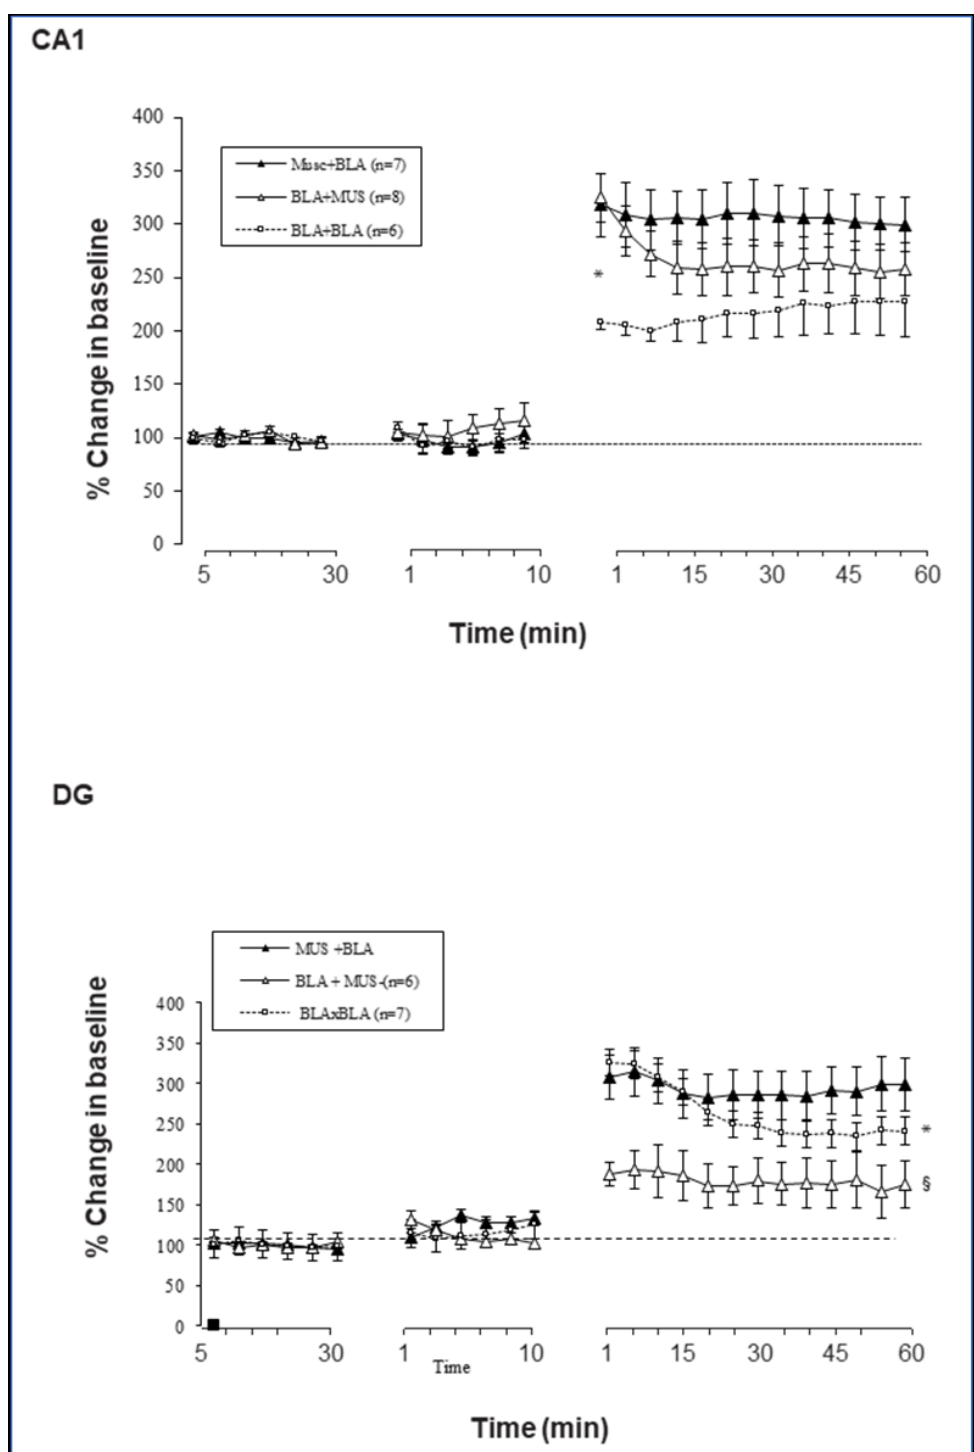
Figure 4. Comparing the effects of repeated (within 10 min) BLA priming to the effects of combined Figure 4. E ff ects of BLA priming with or without intra-BLA muscimol intervention on LTP induction in muscimol and BLA priming. In CA1, repeated BLA priming (BLA_BLA) enhanced the LTP reducing the CA1 ( top ) and the DG ( bottom ). In CA1, muscimol prior to BLA priming reduced the inhibitory e ff ect effect of a single BLA priming, such that the effect was noticeable already during post-tetanic of BLA priming (MUS-BLA significantly di ff erent from BLA-VEH, * p < 0.05). In the DG, muscimol potentiation * ( p < 0.05). In the DG, repeated BLA priming (BLA_BLA) reduced the LTP-enhancing prior to BLA priming had no e ff ect but muscimol after BLA priming prevented the LTP-enhancing e ff ect effect of BLA priming * ( p < 0.05), but not to the extent of muscimol post-BLA priming (BLA-MUS). § , of BLA priming. In fact, it reduced LTP even compared to the control (CONT-VEH) group (* p < BLA_BLA vs BLA-MUS ( p < 0.05). It did not reduce the enhancement during the post-tetanic potentiation period except during the LTP phase. For clarity, we did not include the CONT-VEH groups. However, in CA1, the MUS-BLA group was similar to the CONT-VEH group, and in the DG,